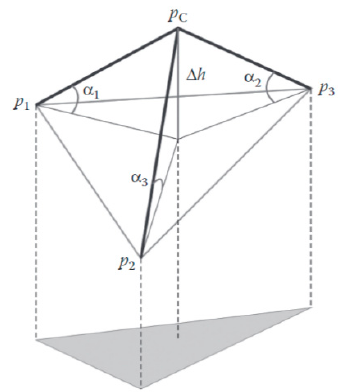
Figure 10. Definition of height di ff erence ( ∆ h ) and the angles ( α i ) used as measures to determine if the point ( p c ) in question is a ground point in adaptive triangulated irregular network (ATIN) algorithm [48].